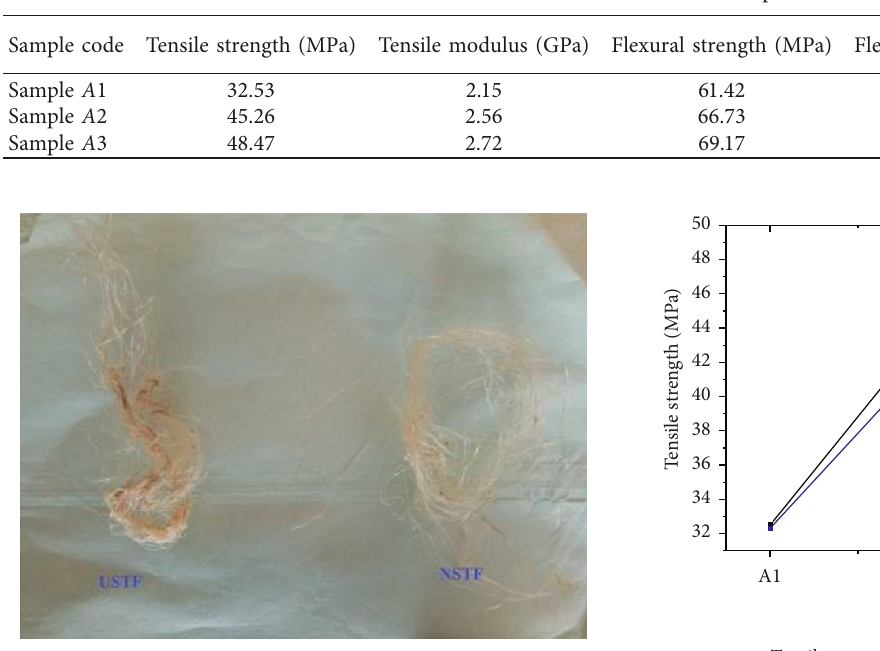
Table 2: Numerical results after the experiment.